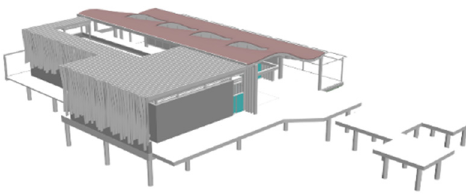
Figure 11. The Lakeside Restaurant dataset pared back and visualised in IFC [26].